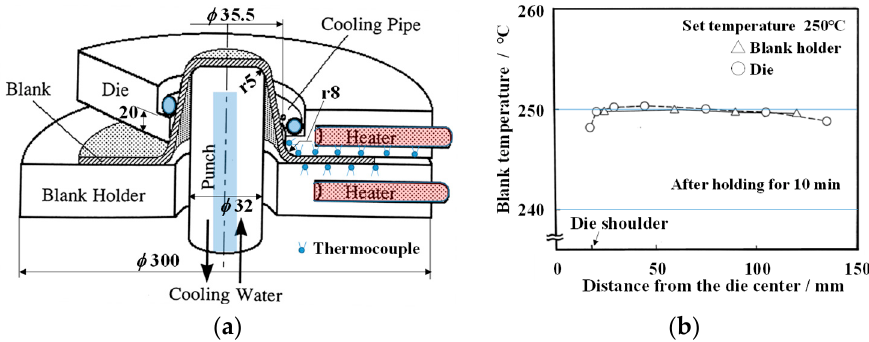
Figure 2. Schematic of tooling for warm cylindrical deep drawing and temperature distribution of the blank. ( a ) Schematic warm deep drawing tooling (unit: mm), ( b ) temperature distribution of the blank.